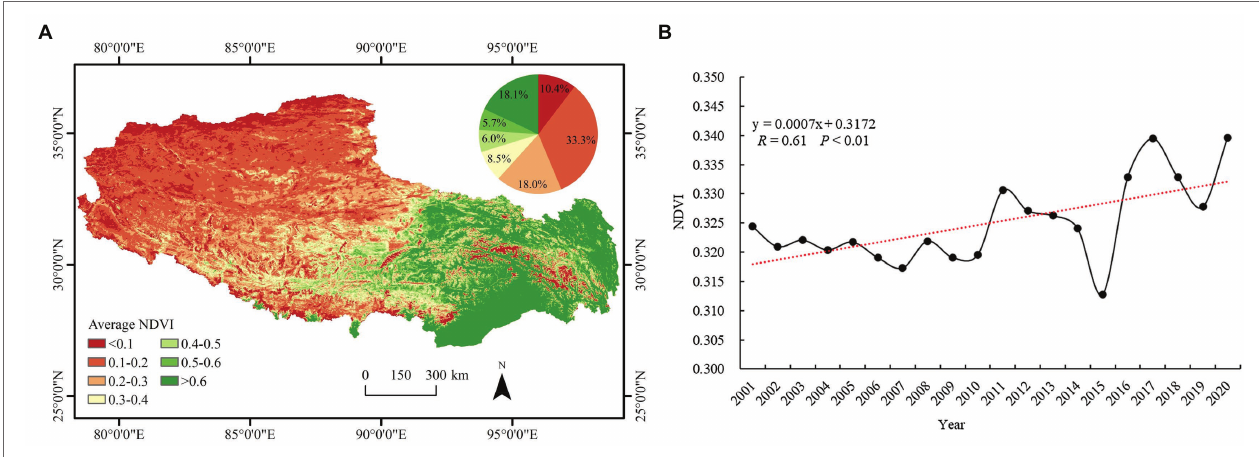
FIGURE 3 | (A) Spatial pattern of the average values and (B) interannual variation in the NDVI in Tibet from 2001 to